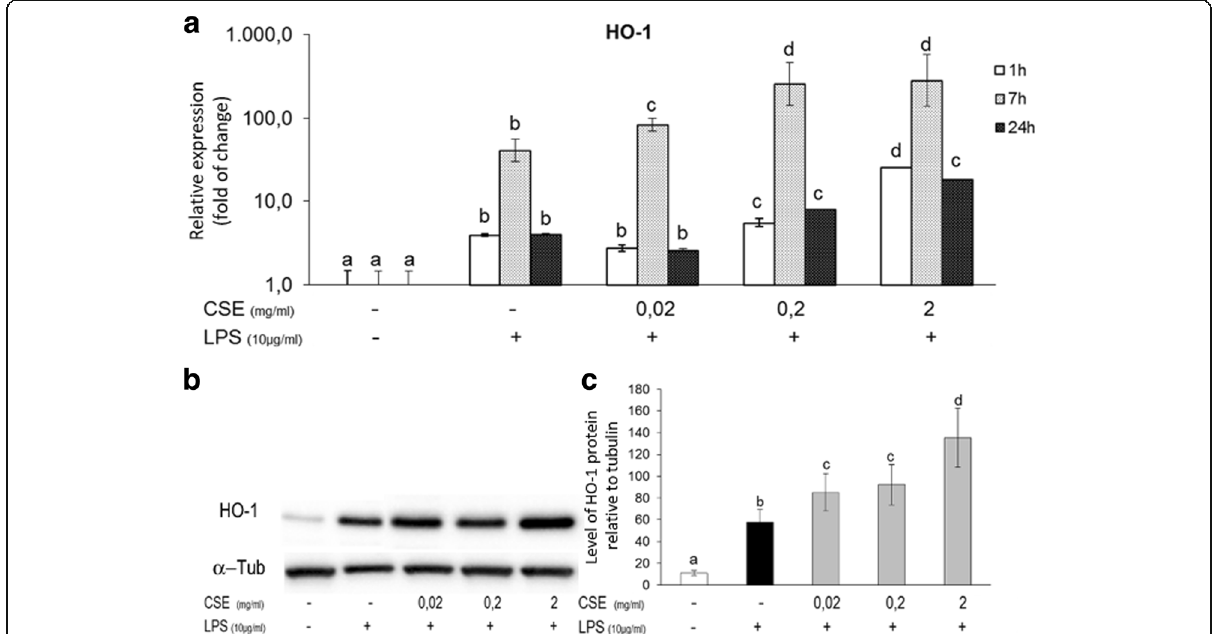
Fig. 3 Effect of Cucumis sativus L. extract (CSE) on LPS induced HO-1 expression. a Expression of HO-1 mRNA in pAECs treated with LPS (10 μ g/ ml) in the presence or absence of increasing doses of Cucumis sativus L. extract (0.02, 0.2, 2 mg/ml). mRNA expression of HO-1 as determined by quantitative PCR. Relative expression was calculated as fold of change in respect to the control cells and error bar represents the range of relative gene expression. Different letters above the bars indicate significant differences. b Representative Western Blot of HO-1 and relative housekeeping α -tubulin were reported. c Expression of HO-1 protein in pAECs treated with LPS (10 μ g/ml) in the presence or absence of increasing doses CSE (0.02; 0.2; 2 mg/ml); data shown are representative of at least three independent experiments and represent the mean±SEM. (AU =Arbitrary Units) Different letters above the bars indicate significant differences (p< 0.05 ANOVA post hoc Tukey ’ s test)